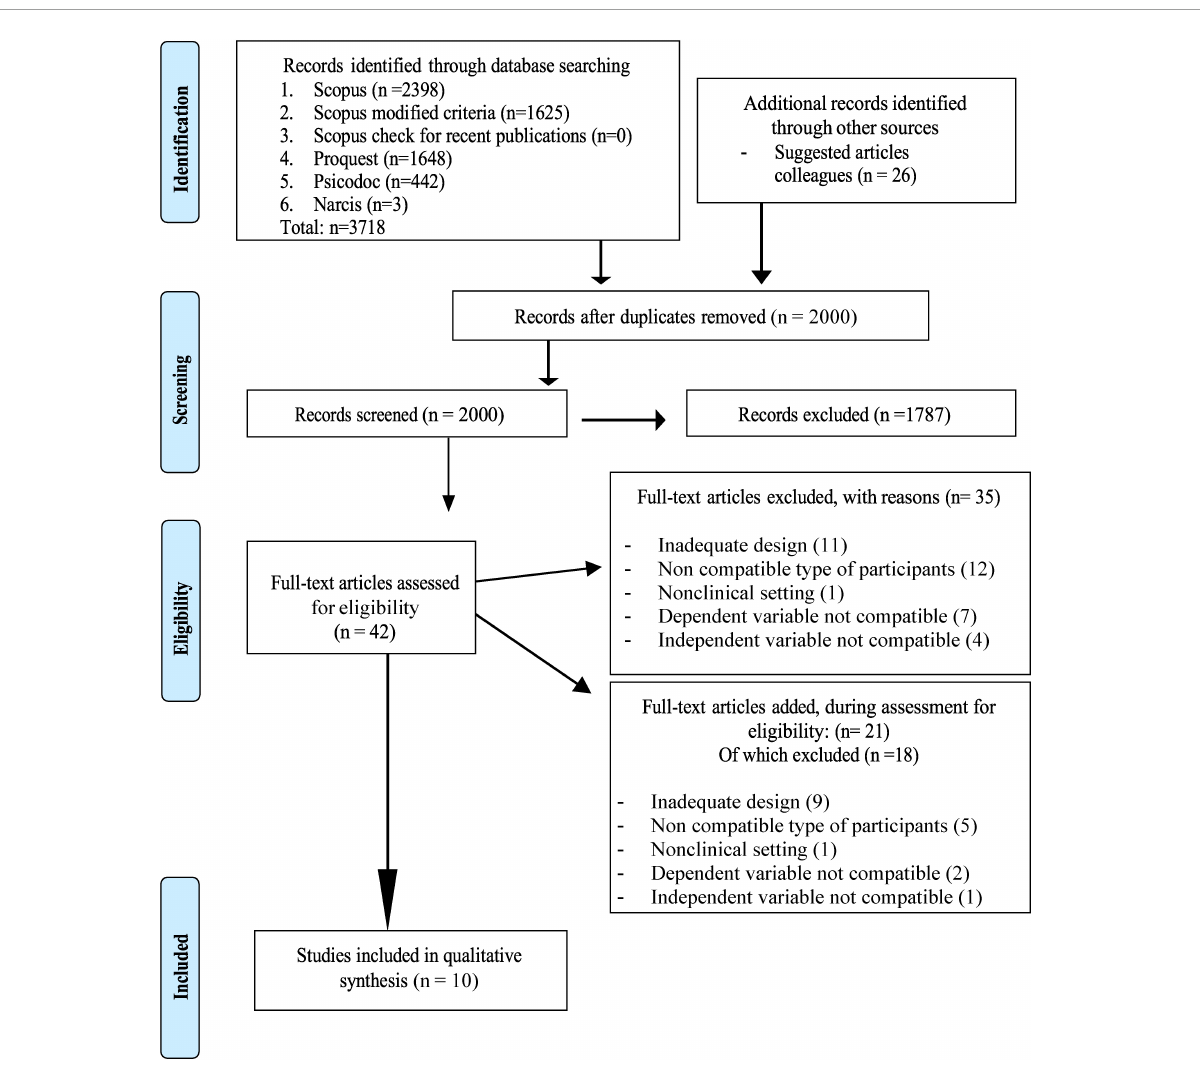
FIGURE1 PRISMA 2009 flow diagram (24). Adapted with permission from the PRISMA team as stated on https://www.prisma-statement.org//PRISMA